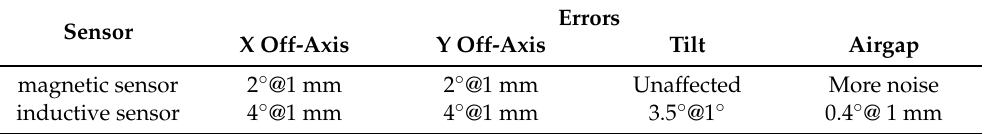
Table 2. Summary of the errors due to mechanical misalignment.